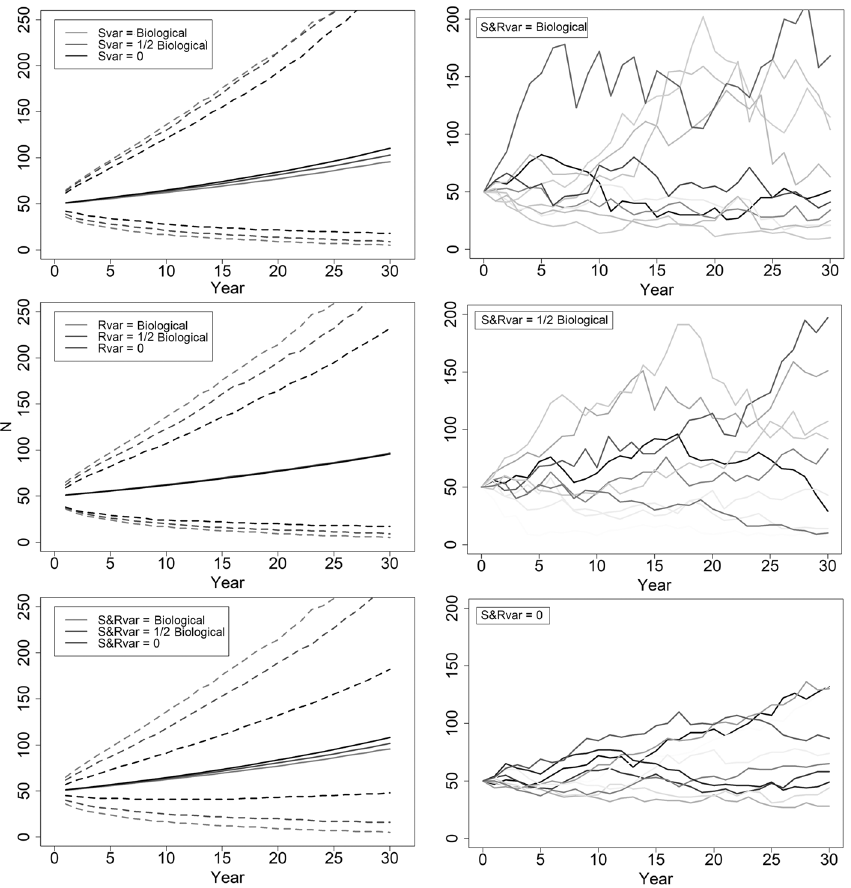
Figure 3. The effects of variability in adult female survivorship and recruitment parameters on the abundance estimates for adult females. Mean abundances are solid lines with dashed lines representing 90% confidence intervals. Upper left: Recruitment variance held at the biological value (0.028), and survivorship variance takes the biological value (0.0127), halved or eliminated. Middle left: Survivorship variance held at biological value, and recruitment variance takes the biological value, halved or eliminated. Bottom left: Variability of survivorship and recruitment vary from both biological, to half biological and variability in both removed. Right 3 panels: 10 randomized abundance simulations with the variability in survivorship (Svar) and recruitment (Rvar) biological, both half biological, and both removed (0). All scenarios have mean recruitment of 0.30 and mean survivorship of 0.90 (stochastic λ =